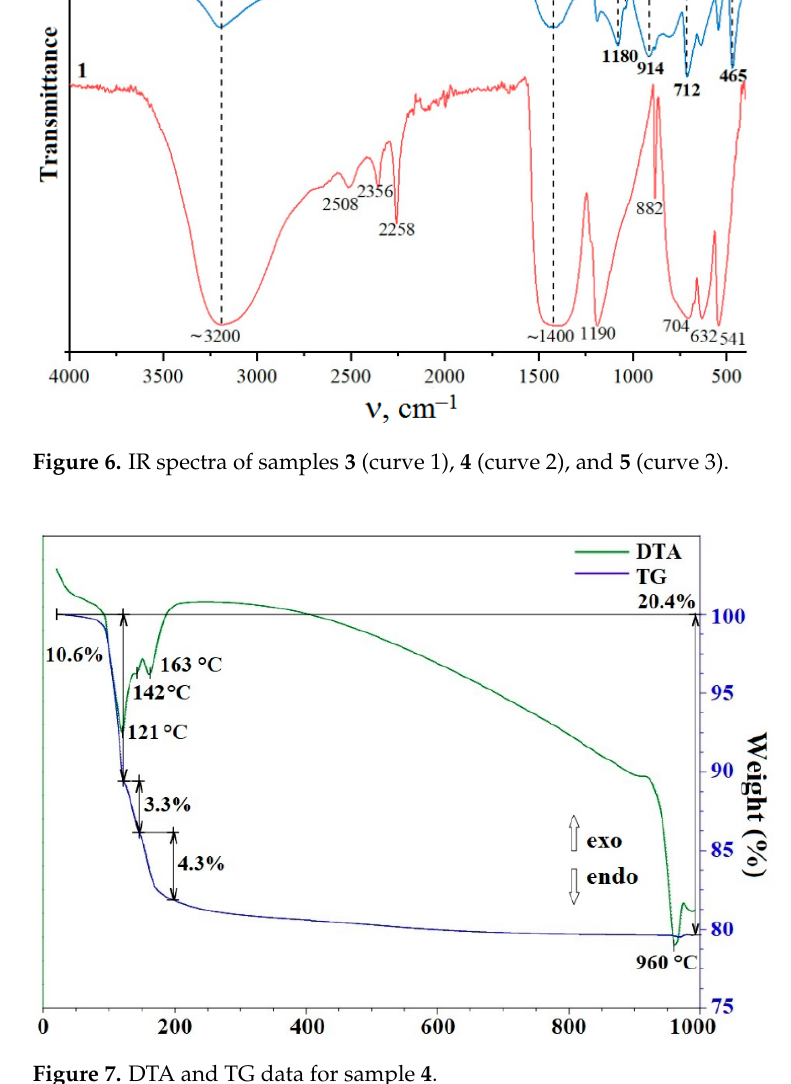
Figure 7. DTA and TG data for sample 4 .